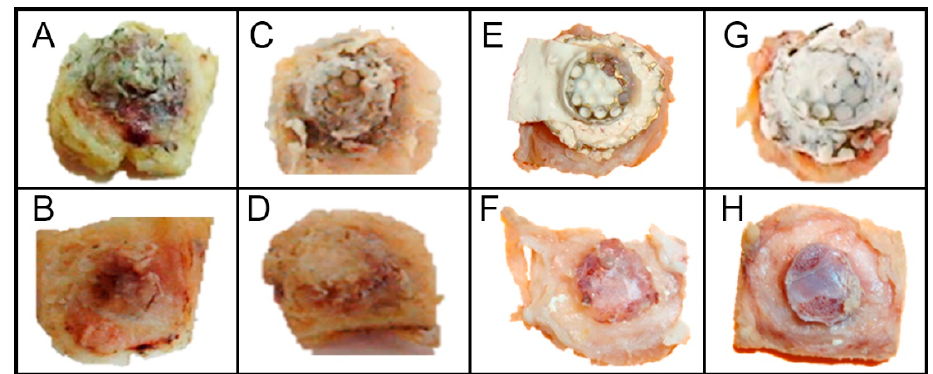
Figure 4. Photographs of the samples removed after 90 days of surgery. Photos of the pieces with the domes and after their removal, showing the difference obtained with the latex coating: Group 1 ( A , B ), Group 2 ( C , D ), Group 3 ( E , F ) and Group 4 ( G , H ).